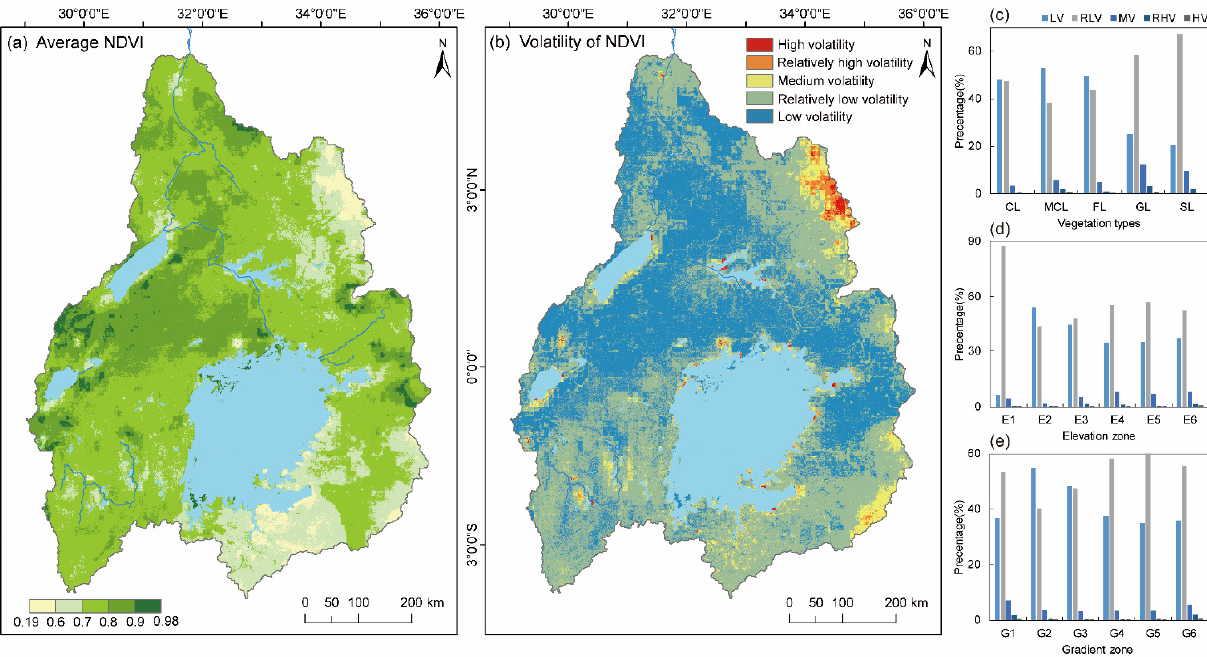
Figure 5. The spatial distribution of the NDVI and volatility in the UWNR from 1982 to 2020. ( a ) Spatial distribution of the average NDVI value. ( b ) Spatial distribution of volatility. ( c ) Percentage of different volatilities in the area of each vegetation type. ( d ) Percentage of different volatilities in the area of each elevation zone. ( e ) Percentage of different volatilities in the total area of each gradient zone.